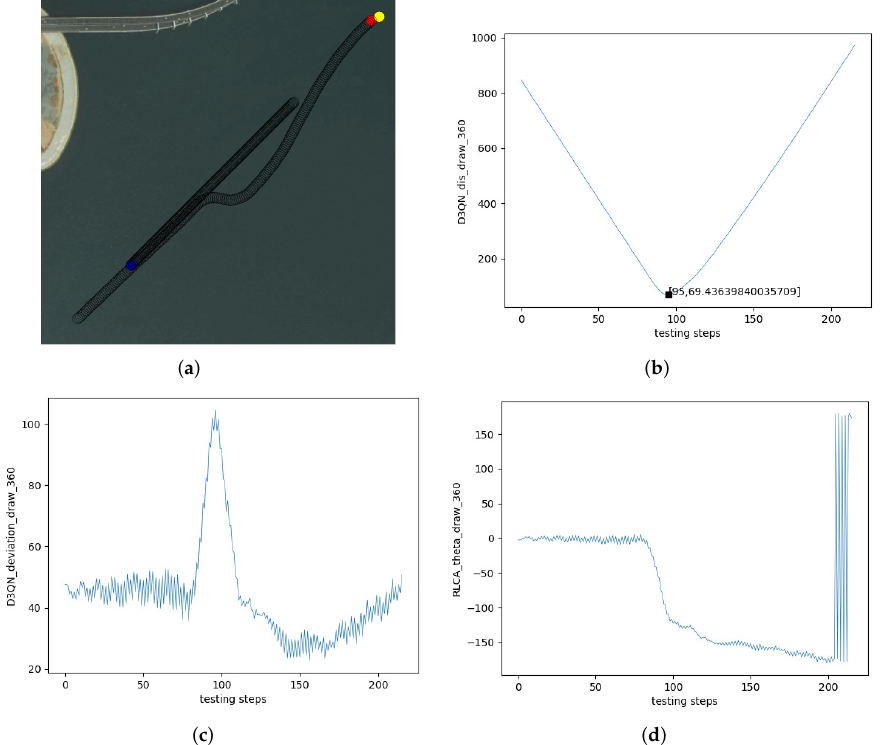
Figure 17. Test effect of the head-on encounter. ( a ) Head-on. ( b ) The distance between two USVs. ( c ) The course of the own USV. ( d ) θ of the own USV.